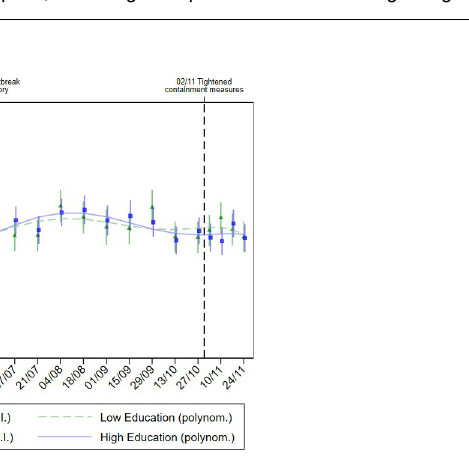
Fig 4. Perceived adequacy of media coverage in individuals with different education levels during the pandemic. Adjusted predictions from linear regressions with interaction between education level and calendar week (categorial and metric), adjusted for age group, gender, repeat respondent, community size, and federal state.